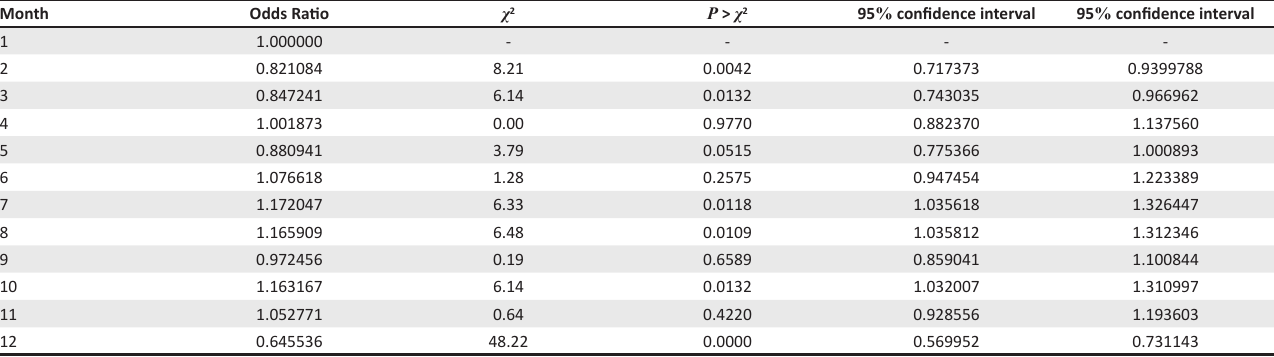
TABLE 1-A1: Case–control evaluation of monthly calf wastage using logistic regression analysis.